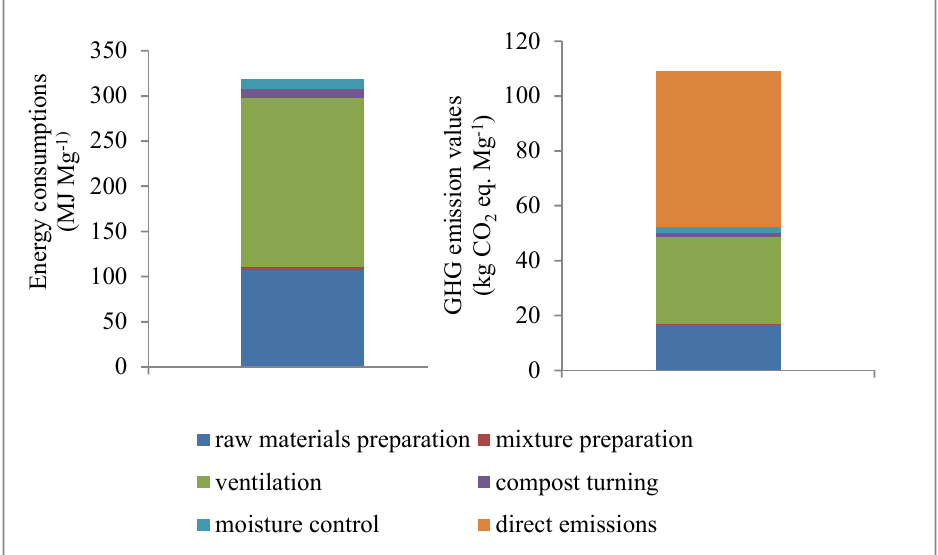
Figure 2. Energy used (MJ Mg − 1 compost produced) and GHG emission values (kg CO 2 eq. Mg − 1 compost produced) for the composting process divided by each treatment operation.